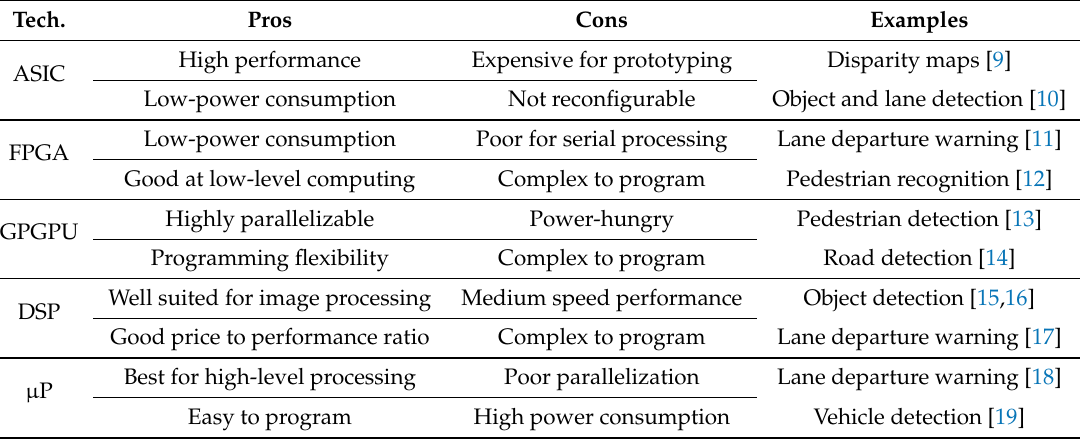
Table 1. Examples of latest-generation embedded ADAS using different HW technologies. Tech.